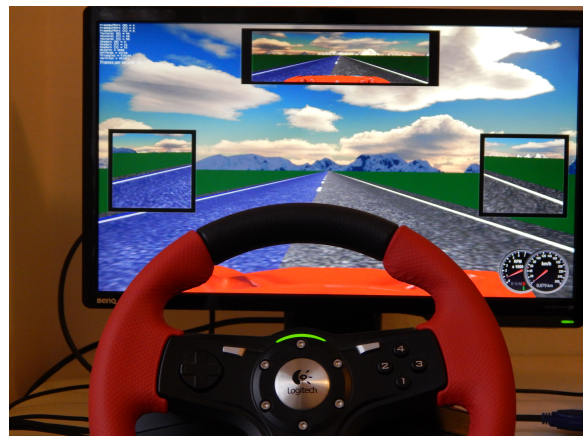
Figure 3. The basic human-in-the-loop simulation setting for human factor